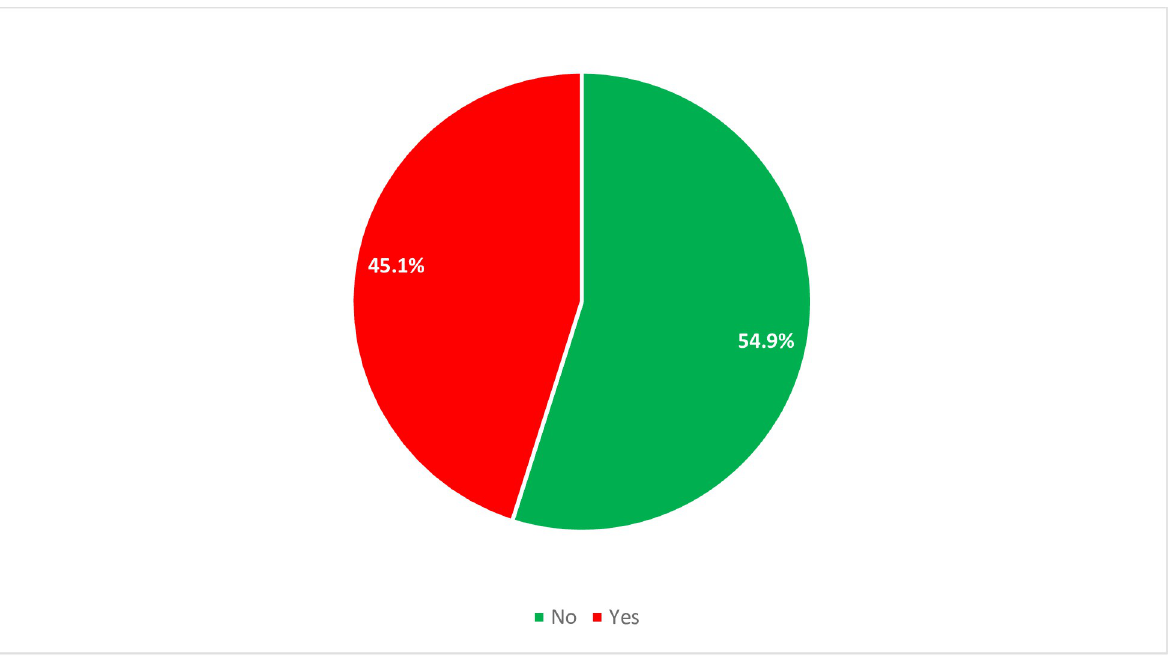
Fig 1. Proportiion of depression among prisoners included the study, Wollega zones, Western Ethiopia, 2019.